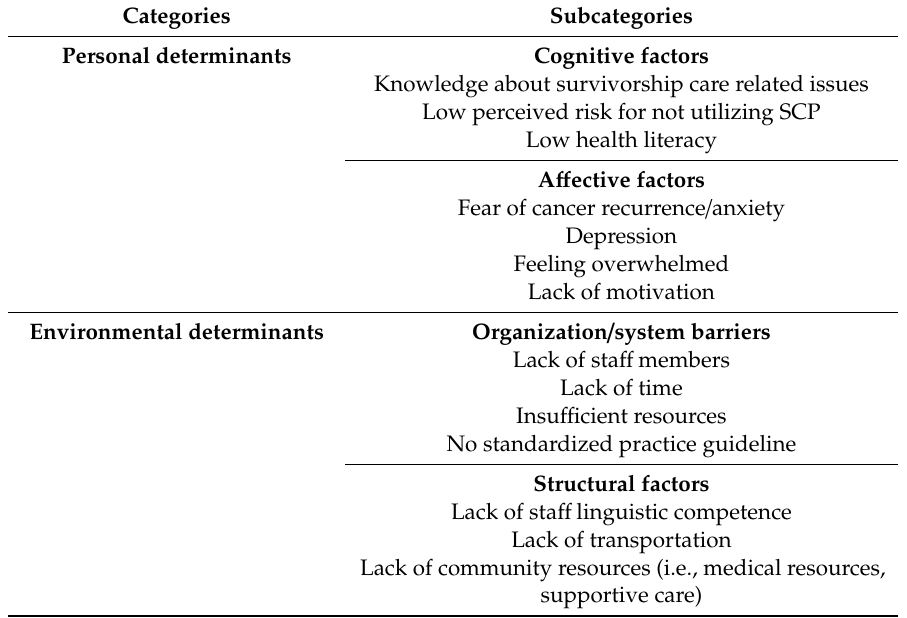
Table 2. Determinants Impacting the Use of Survivorship Care Plan